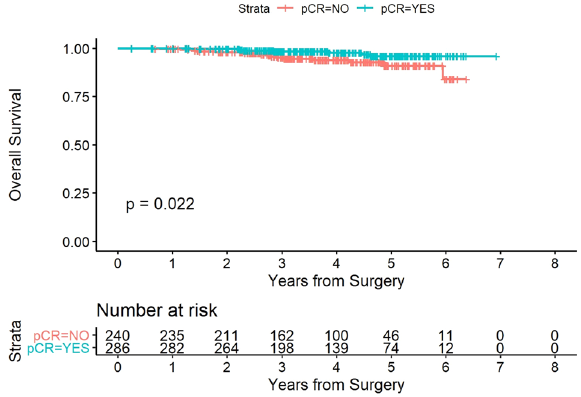
Fig. 4 Overall survival strati fi ed in pCR versus non-pCR groups. The red and blue curves show the estimated overall survival of the patients in the non-pCR group and pCR group,